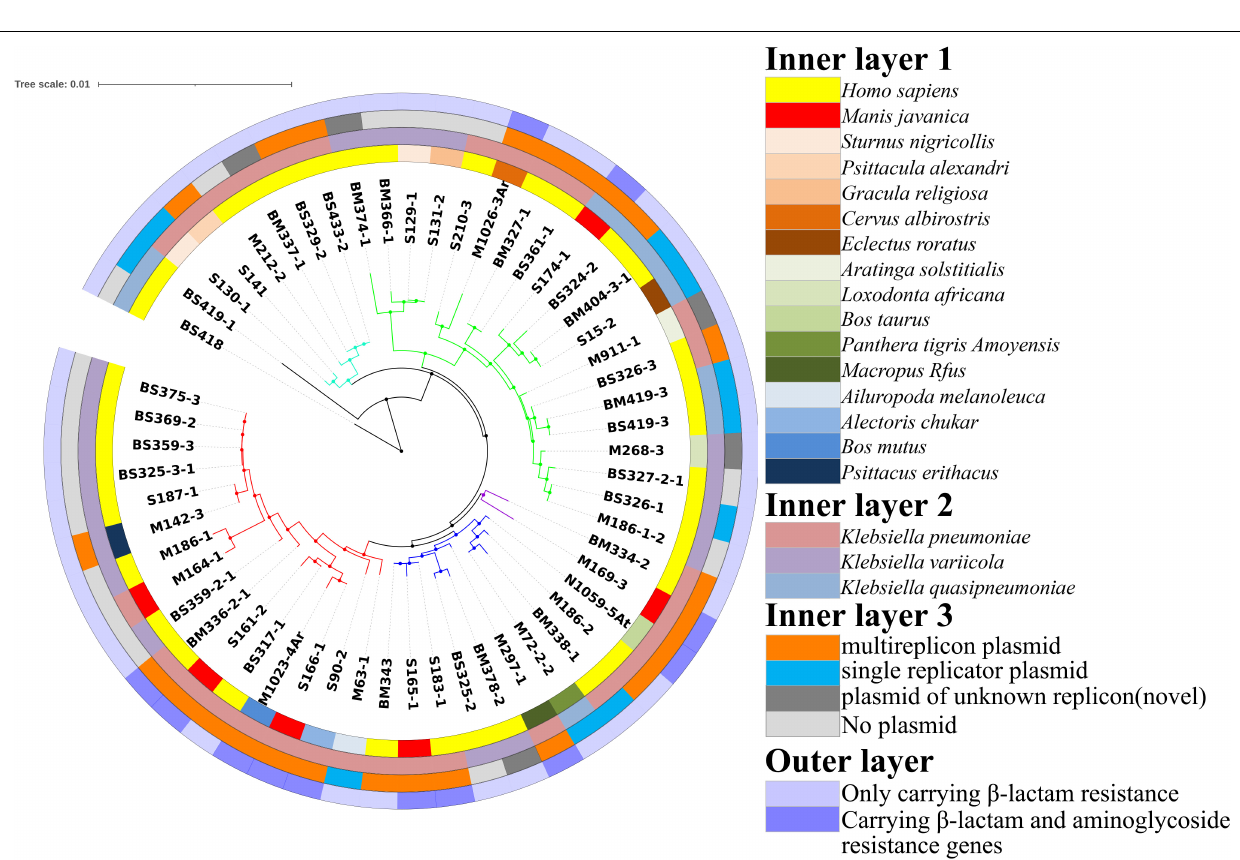
Frontiers in Microbiology |